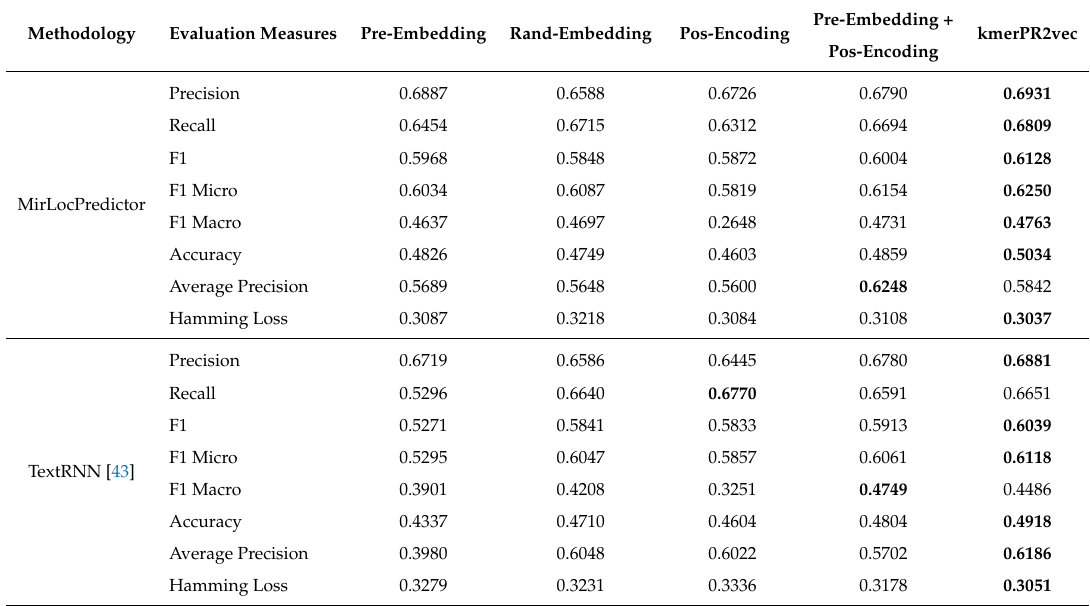
Table 2. Performance comparison between the proposed kmerPR2vec and 4 other feature representation approaches on account of 4-mers using two classification